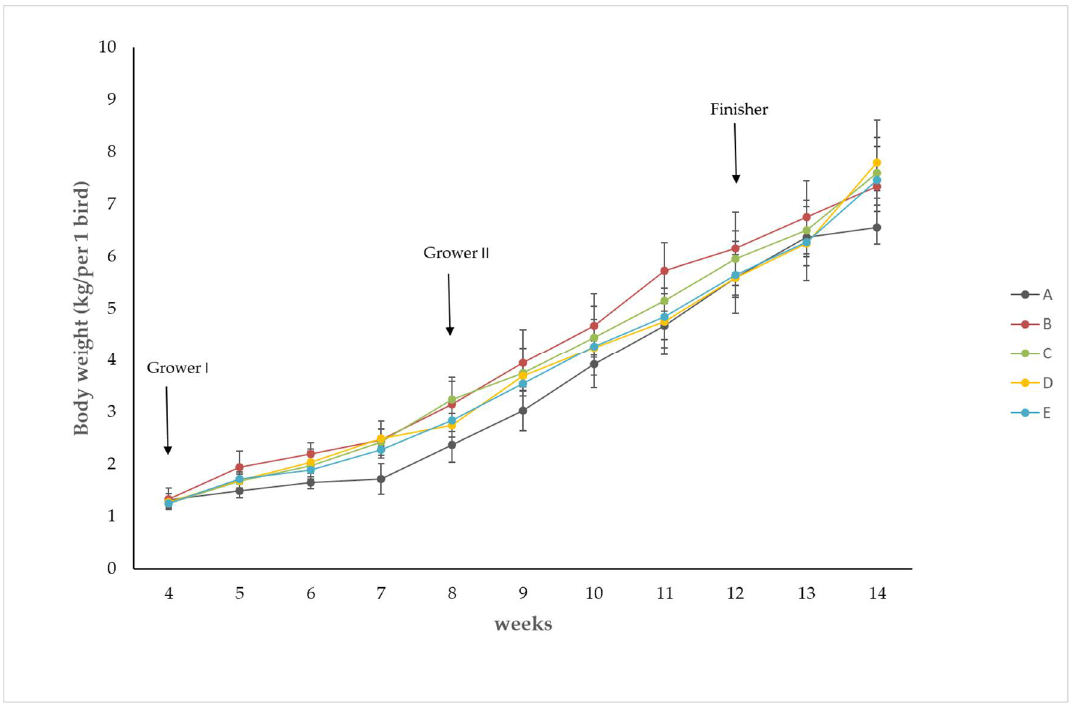
Figure 1. Time course of body weight change as influenced by corn silage and different diet cation– anion differences. To better visualize the statistical significance, values from Figure 1 are additionally presented in Table 4.